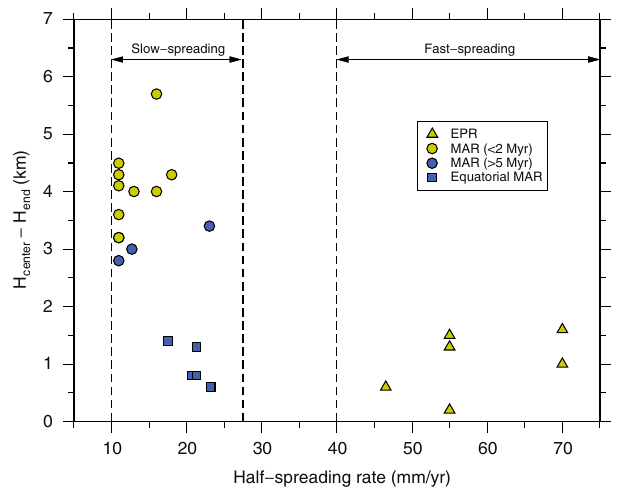
Fig. 1 | Crustal thickness variation versus spreading rate. Crustal thickness (H) difference between segment centres and segment ends as a function of spreading rate. Only the crustal thickness constrained by active-source seismic data is con- sidered. The crustal thickness data from the Atlantic Ocean are selected following two criteria: (1) systematically along-axis crustal thinning is observed within the second-order ridge segment and (2) the crustal thicknesses at segment centre and at least one segment end are measured. The blue squares show the difference between the average crustal thickness at the transform fault, fracture zone and pseudo-fault region and the average crustalthickness of segments obtained inthis study.Whenthecrustalthicknessesofbothendsofasegmentareavailable,theone with thinner crust is plotted. The crust at the ends of slow-spreading ridges is generally ≥ 2.8kmthinnerthanthatattheassociatedsegmentcentres.DataforEast Paci fi c Rise (EPR), South and North Mid-Atlantic Ridge (MAR) are given in Sup-